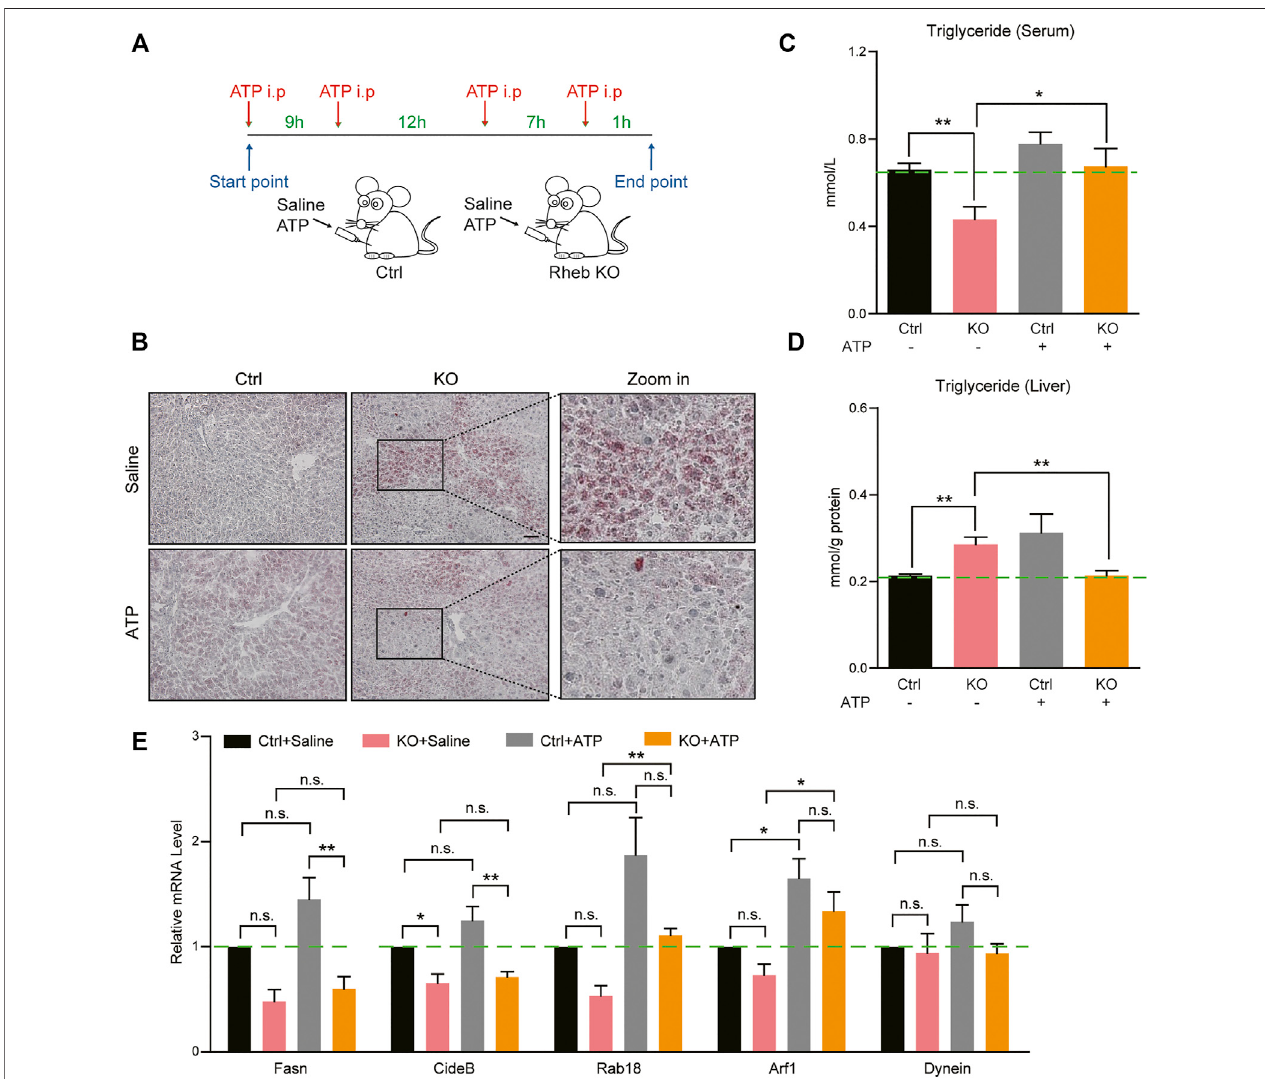
FIGURE3| ATPsupplementsamelioratehepatosteatosisin Rheb KOmice. (A) Aschematicillustrationthatcontainscontroland Rheb KOmiceinjectedwithsaline or ATP (dosage: 125 μ g/g) four times. (B) Images of Oil Red O staining showing the decreasing of lipid droplets in the liver of Rheb KO mice by ATP treatment. (C-D) Biochemicalassaysshowingthedecreasedtriglyceridelevelintheliverandincreasedintheserumin Rheb KOmicebyATPtreatment. (E) mRNAlevelsofgenesrelated to lipid droplet secretion in the liver of Rheb KO mice by ATP treatment. Data represent mean ± SEM. *p < 0.05, **p < 0.01. n.s, no statistical signi fi cance.